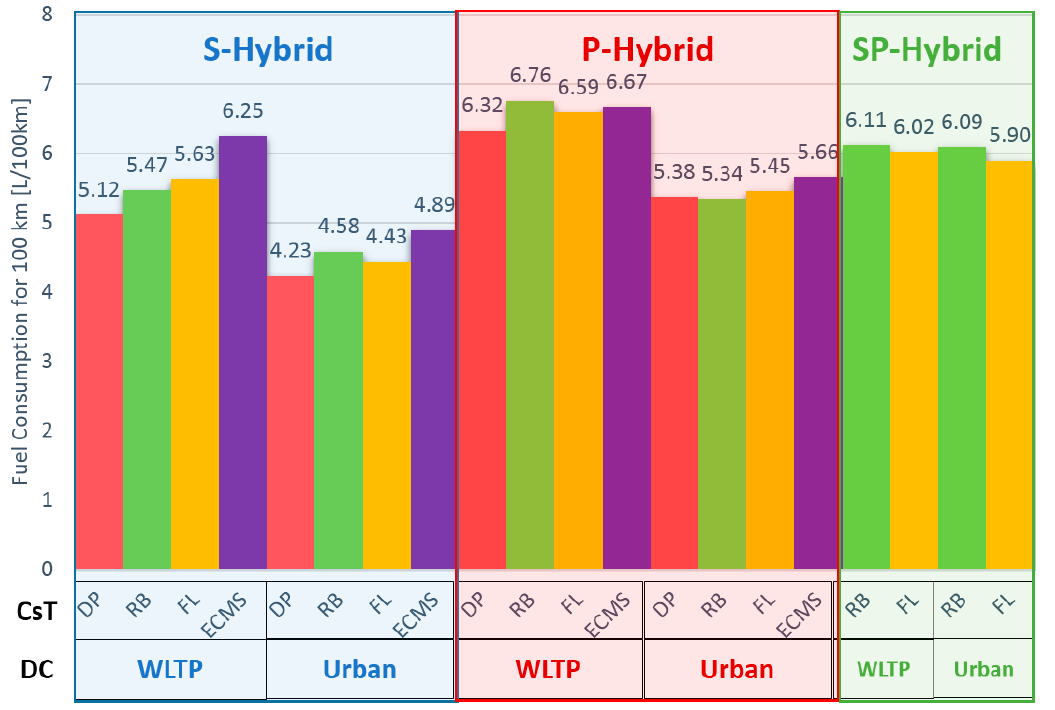
Figure 17. Family car CsT analysis results.